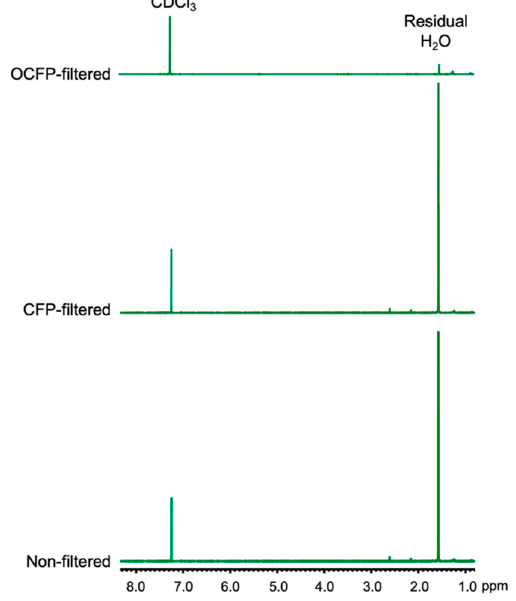
Figure 5. 1 H NMR spectra (500 MHz) of wet deuterated chloroform (CDCl 3 , bottom), CFP-filtered CDCl 3 (middle), and OCFP-filtered CDCl 3 (top).